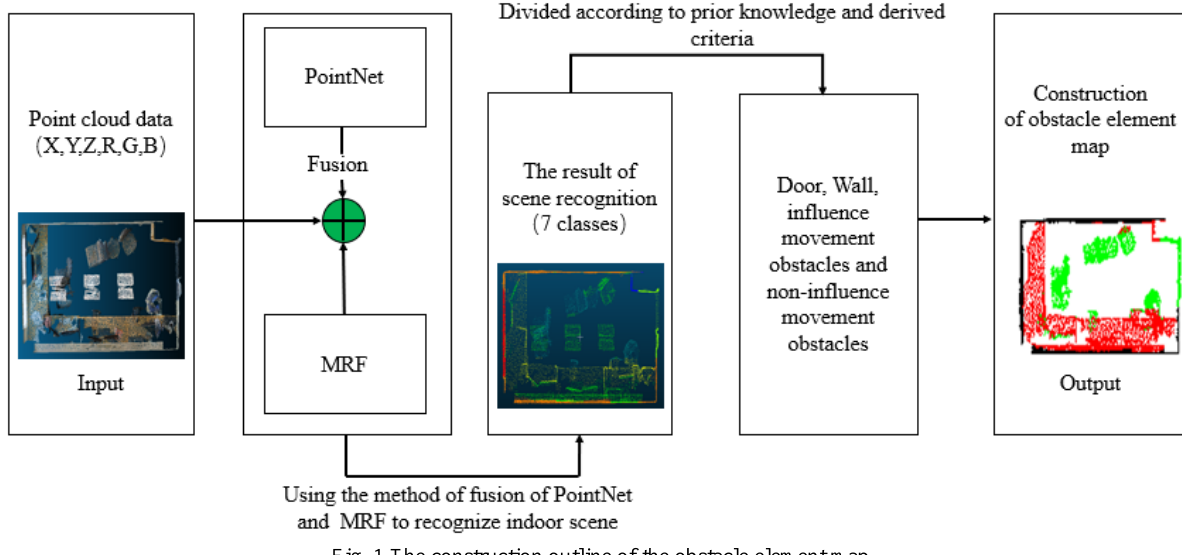
Fig. 1 The construction outline of the obstacle element